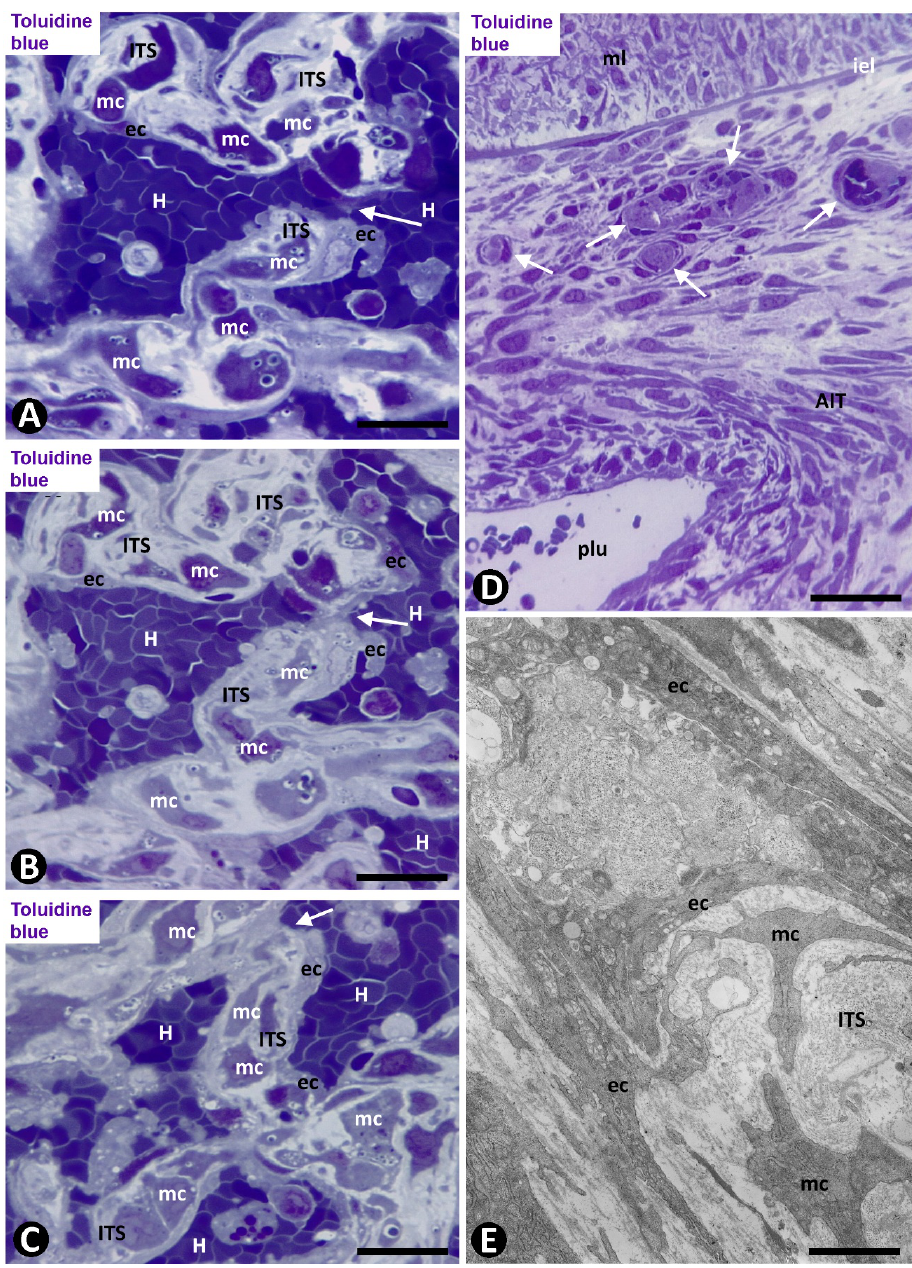
Figure 9. Angiogenesis, remodeling and vessel regression in experimental occluded arterial segments; mc: myointimal cells, ec: endothelial cells, H: red blood cells, ITS: interstitial tissue structure. ( A – C ) Appearance/disappearance and continuities/discontinuities of mature pillars in serial semithin sections (the arrows point to a pillar that contacts, or not, with another pillar, depending on the serial semithin section). ( D ) Artery with intimal thickening and a preferential lumen (plu). Note regressive vessels (arrows) within the intimal thickening. ( E ) Ultrastructural image of a regressive vessel and an ITS with persistent myointimal cells. ( A – E ) Semithin sections. Toluidine blue. ( F ) Ultrathin section. Uranyl acetate and lead citrate. Bar: ( D ): 30 μ m; ( A – C ): 10 μ m; ( E ): 2 μ m.